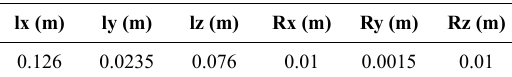
Table 1. Geometric data used in the simulation